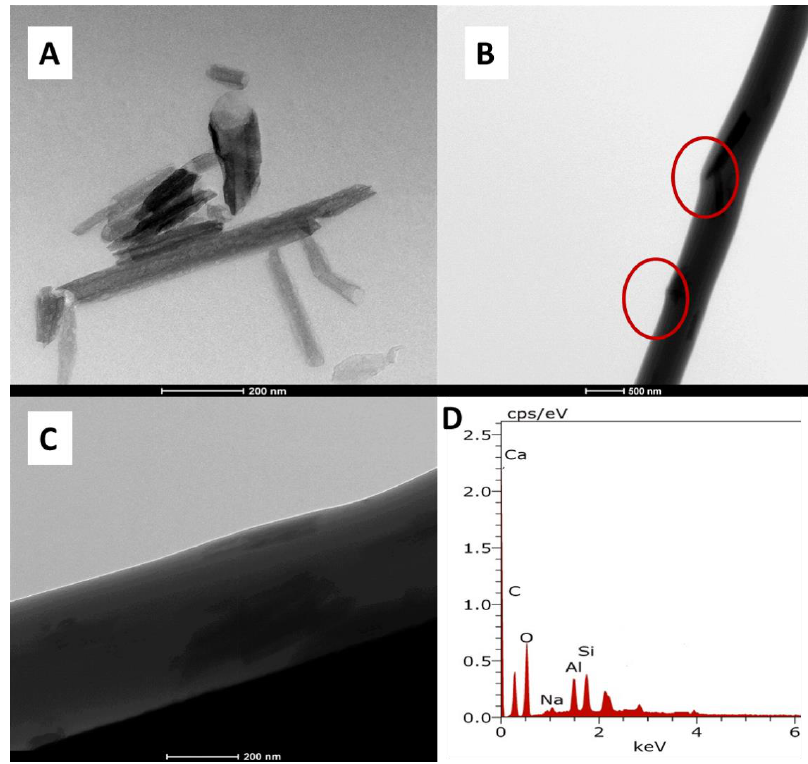
Figure 2. Transmission electron microscope images of ( A ) Halloysite nanoclay ( B , C ) copolyamide – HA composite nanofiber at different magnifications, ( D ) EDX spectra of COHA 1.5